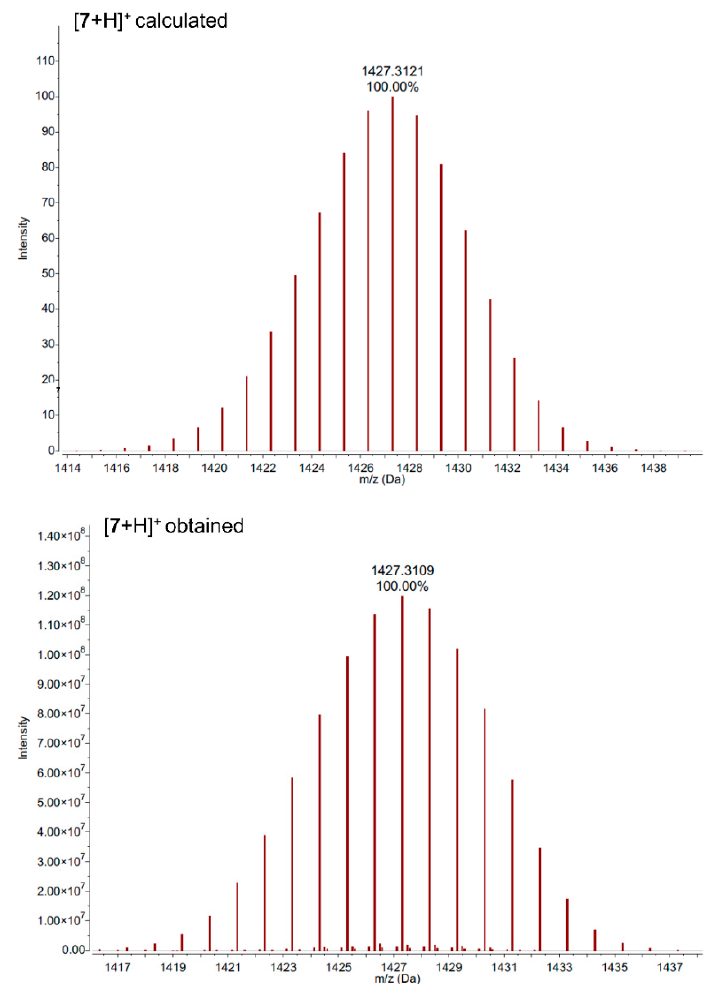
Figure 6. Comparison of the isotopic pattern of the calculated (top) and measured signal (bottom) of [ 7 + H] + [41].